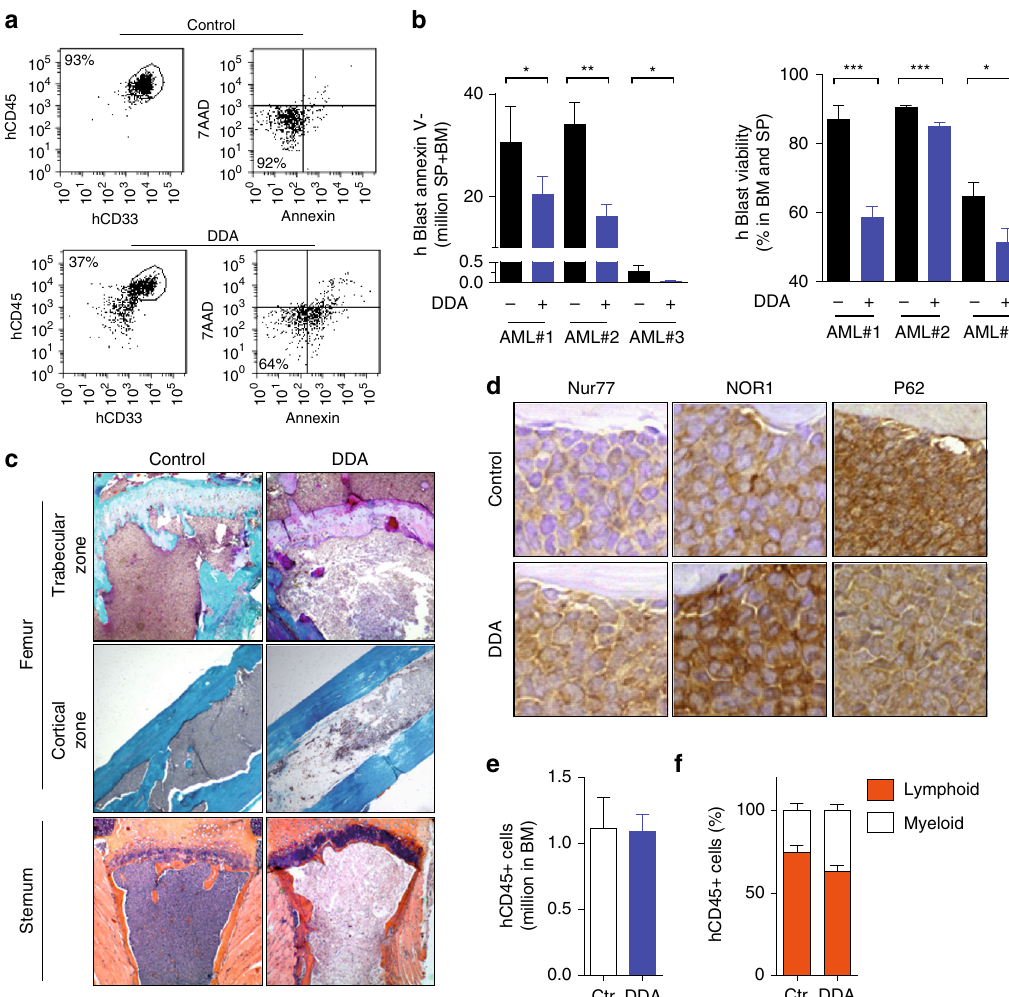
Fig. 8 DDA exerts anti-leukemic activity in vivo in patient AML samples. Primary cells from AML patients were injected i.p. into irradiated NSG mice (three AML patients were tested separately). After validation of tumor engraftment, mice were treated with DDA (20 mg/kg/d, i.p.) or control (vehicle) for 19 days. a Representative fl ow cytometry analysis showing the selection of the human AML population (hCD45+hCD33+) and analysis of cell viability by Annexin-V/7AAD staining. b Human leukemic cell content in the hind limb bone marrow (BM) and spleen (SP) was measured by fl ow cytometry using human anti-CD45 and anti-CD33 antibodies. The viability of human CD45+CD33+ cells was determined by Annexin-V staining and fl ow cytometry analysis, * P < 0.05, ** P < 0.01, *** P < 0.001, t -test. c Histological analysis of femur and sternum sections from mice injected with primary AML cells (AML#1), stained with Goldner (femur) and HE (sternum). d Histological analysis of bone marrow staining for Nur77, NOR1, and P62. Normal human CD34+ cells from a healthy donor were implanted intravenously into NSG mice and treated with vehicle or DDA for 3 weeks (20 mg/kg/day, i.p.). e Engraftment was quanti fi ed by assessing the percentage of hCD45+ cells in the BM. f The percentage of human myeloid (CD45+/CD33+) and lymphoid (CD45+/CD19+) cells was determined by fl ow cytometry. e , f Bars represent